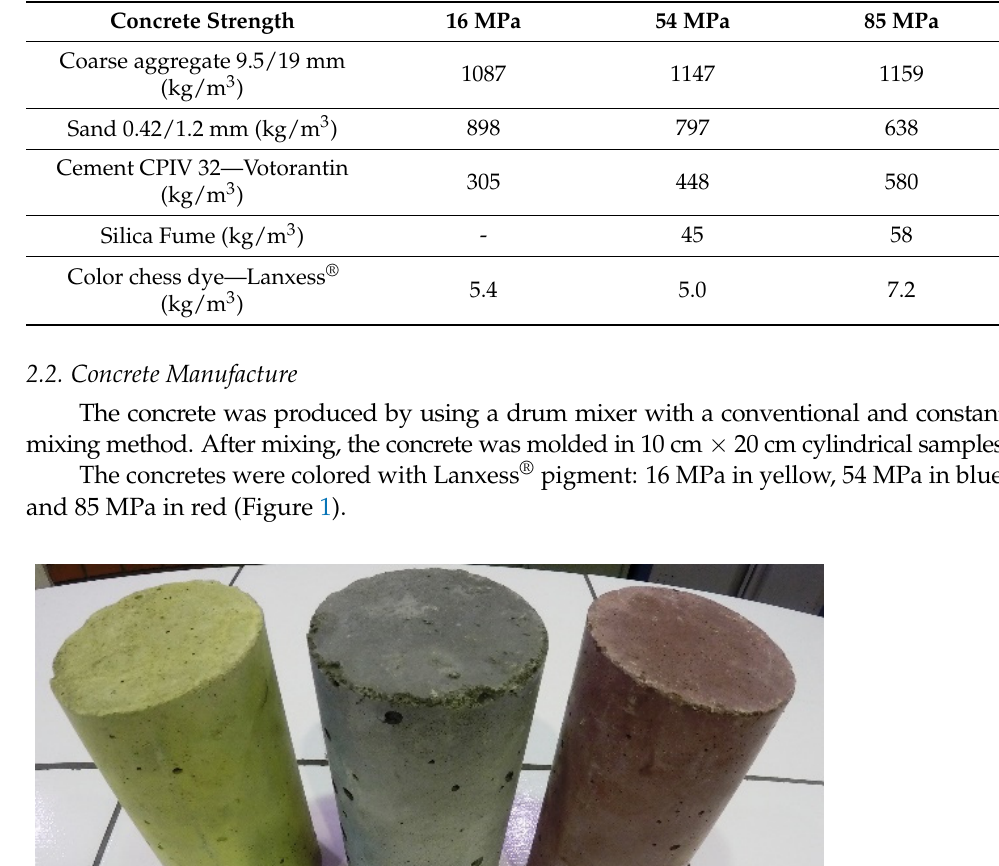
Table 1. Concrete mix design.